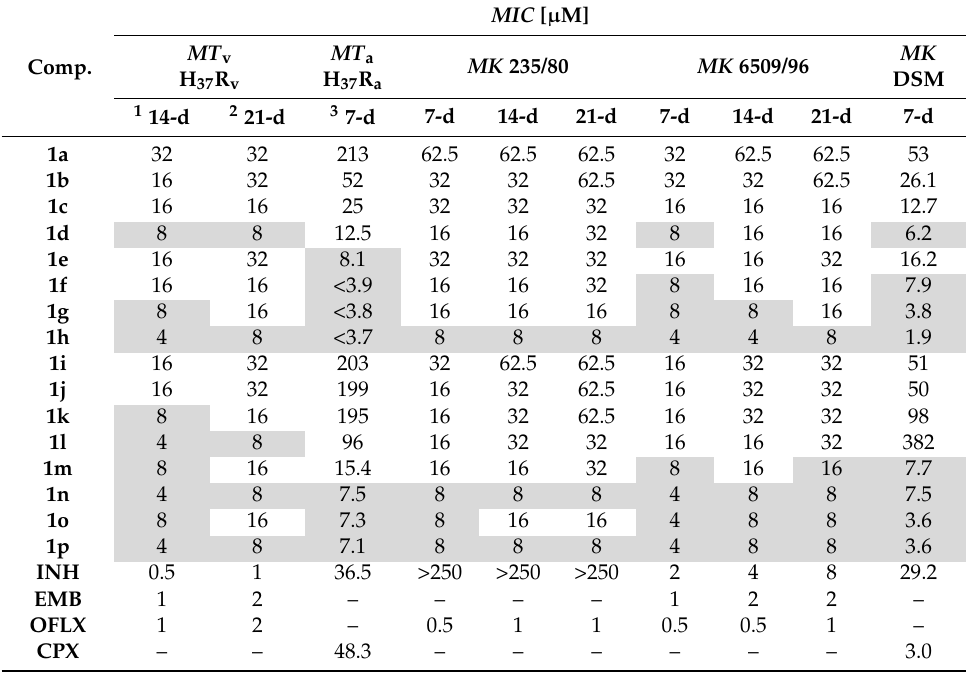
Table 6. The in vitro activity ( MIC values in µ M units) of investigated compounds 1a – p and reference drugs isoniazid (INH), ethambutol (EMB), ofloxacin (OFLX) and ciprofloxacin (CPX) against M. tuberculosis CNCTC My 331/88 ( M. tuberculosis H 37 R v ; MT v H 37 R v ), M. tuberculosis H 37 R a ATCC 25177 ( MT a H 37 R a ), M. kansasii CNCTC My 235/80 ( MK 235/80), M. kansasii 6509/96 ( MK